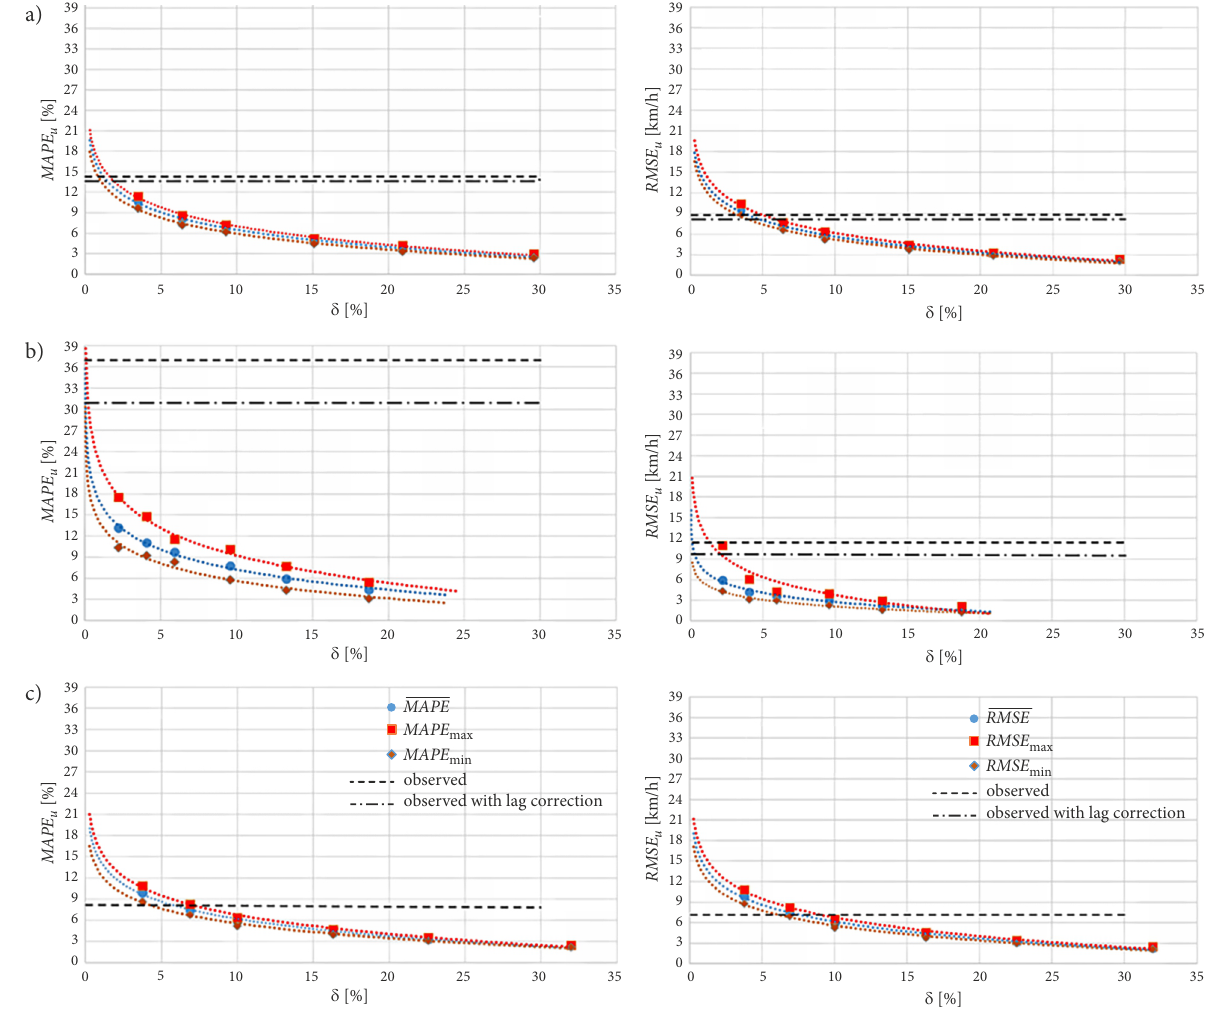
Figure 7. MAPE u and RMSE u values from the simulated FCD and commercial FCD sets versus PR for: a – whole-analysis period; b – am-peak period; c – off-peak